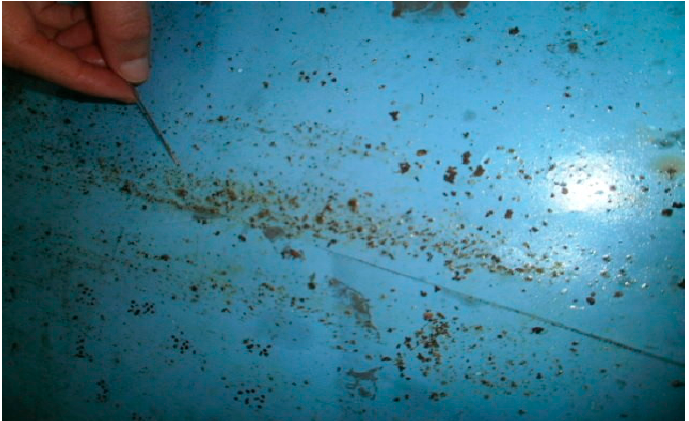
Figure 9. Counting varroa.